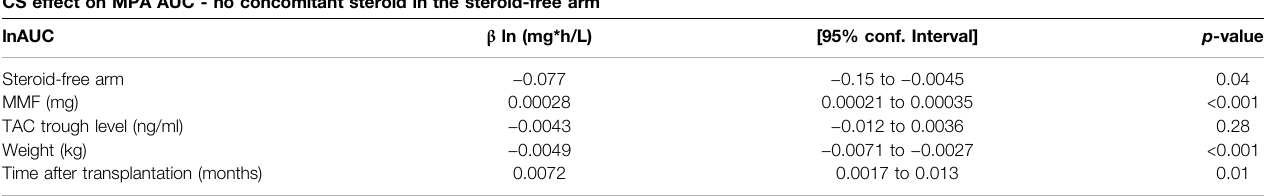
TABLE 3 | Multilevel mixed-effects linear regression using natural log transformation based on all MPA measurements except those in the steroid-free arm performed on concomitant steroid therapy ( n (cid:1) 462). CS effect on MPA AUC - no concomitant steroid in the steroid-free arm